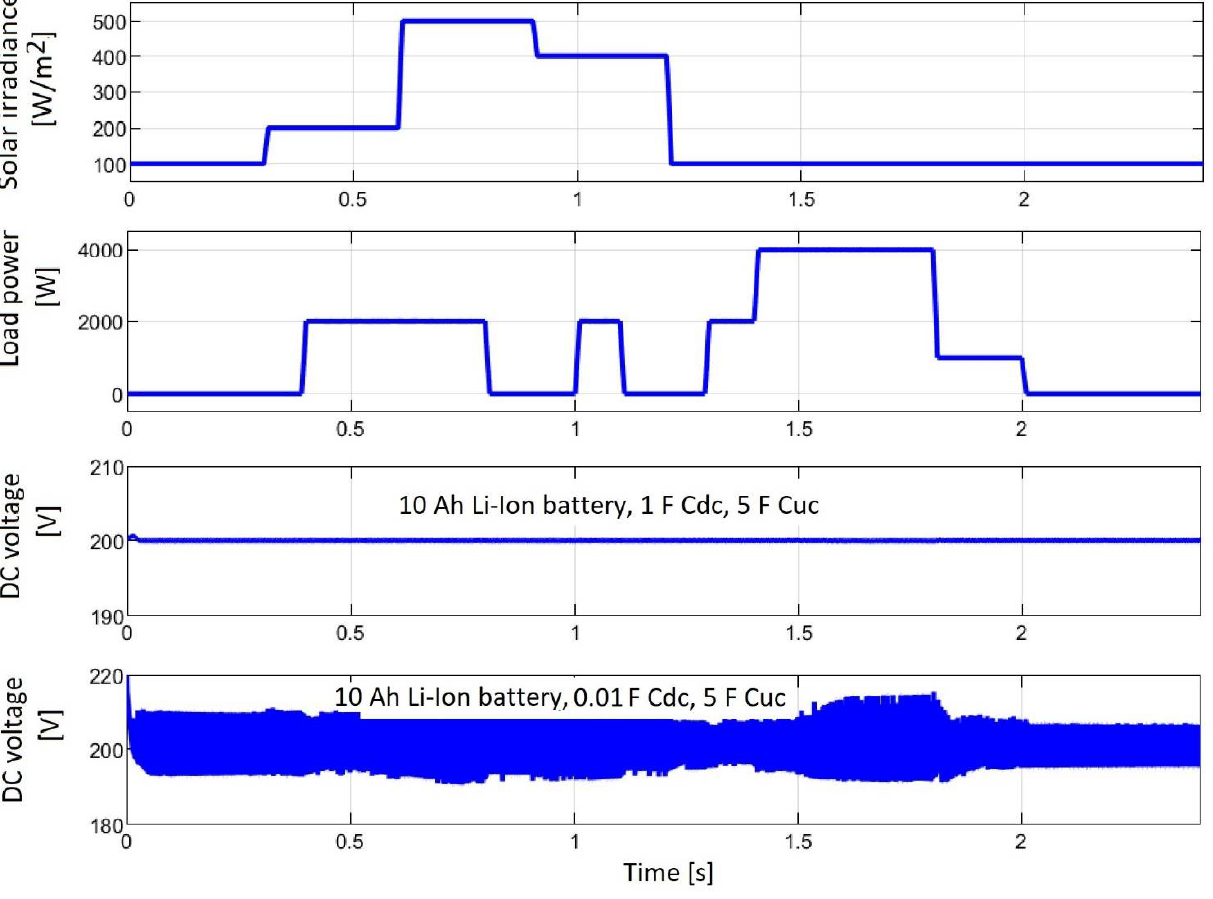
Figure 16. The DC voltage variation of the PV/FC/ESS system using strategy S2 in the scenario SC3.